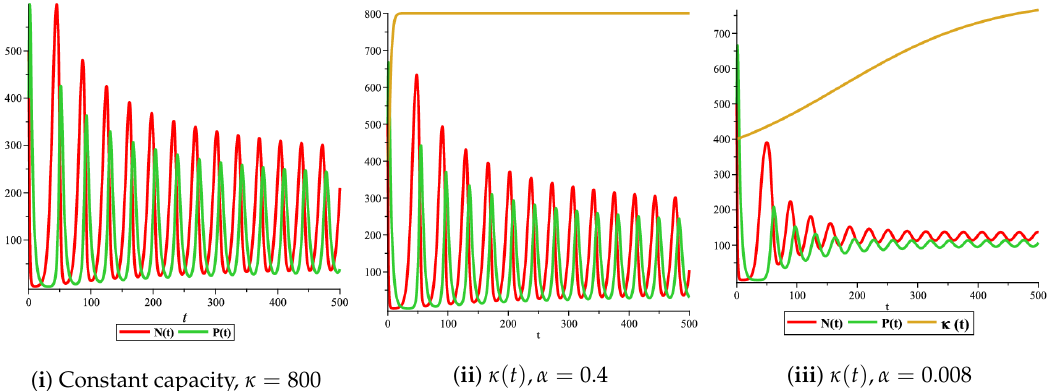
Figure 5. Effect of logistic carrying capacity on prey–predator model with Holling type II functional response for κ 1 = 300, κ 2 = 500, r = c = 0.25, a = b = 0.0025, γ =